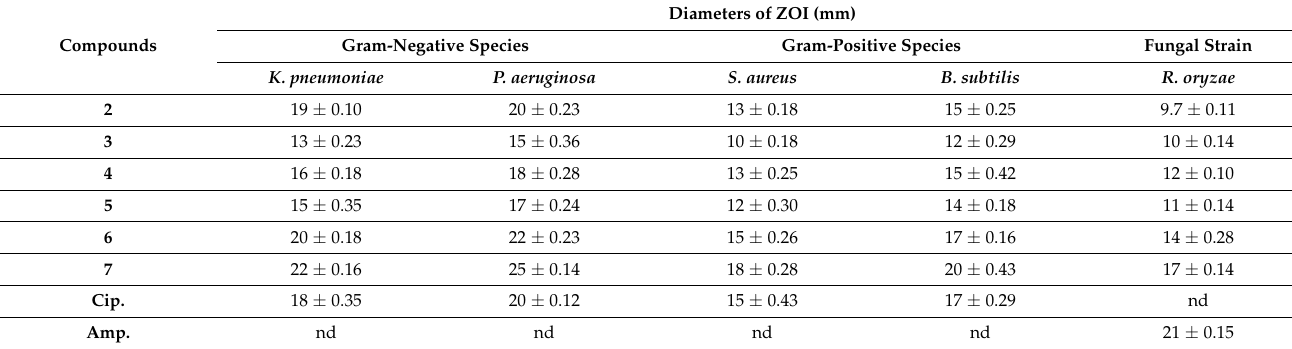
Table 1. Antimicrobial properties and ZOI diameters of six newly synthesized compounds against particular pathogenic